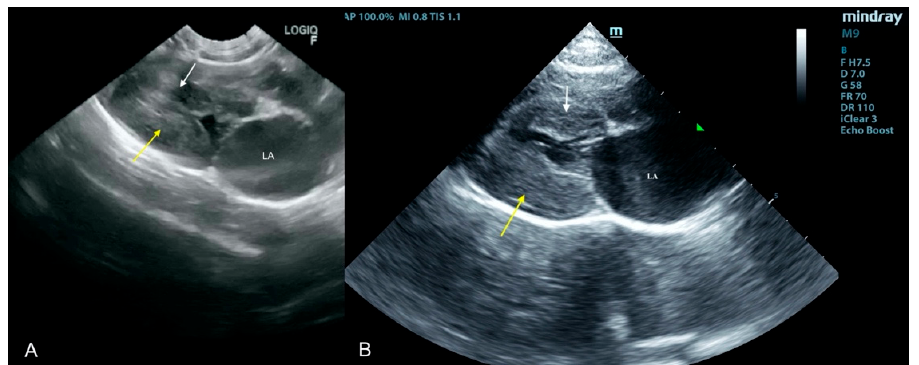
Figure 7. Thickening of left ventricle walls. LA—left atrium, yellow arrow points to the free wall of the left ventricle, white arrow points to the septum. ( A ) Scan from a microconvex probe obtained during focused cardiac ultrasound examination (GE Healthcare Logiq F6). ( B ) Scan from a phased array probe obtained during echocardiography examination performed by a board-certified echocardiography specialist (Mindray M9).